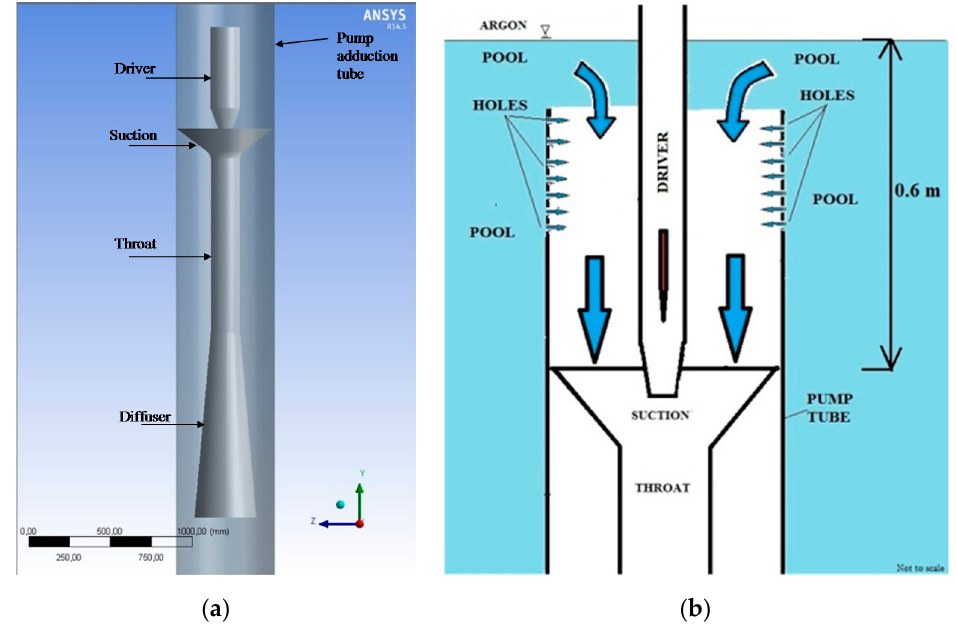
Figure 4. Lead jet pump: ( a ) geometry model; ( b ) flow patterns.